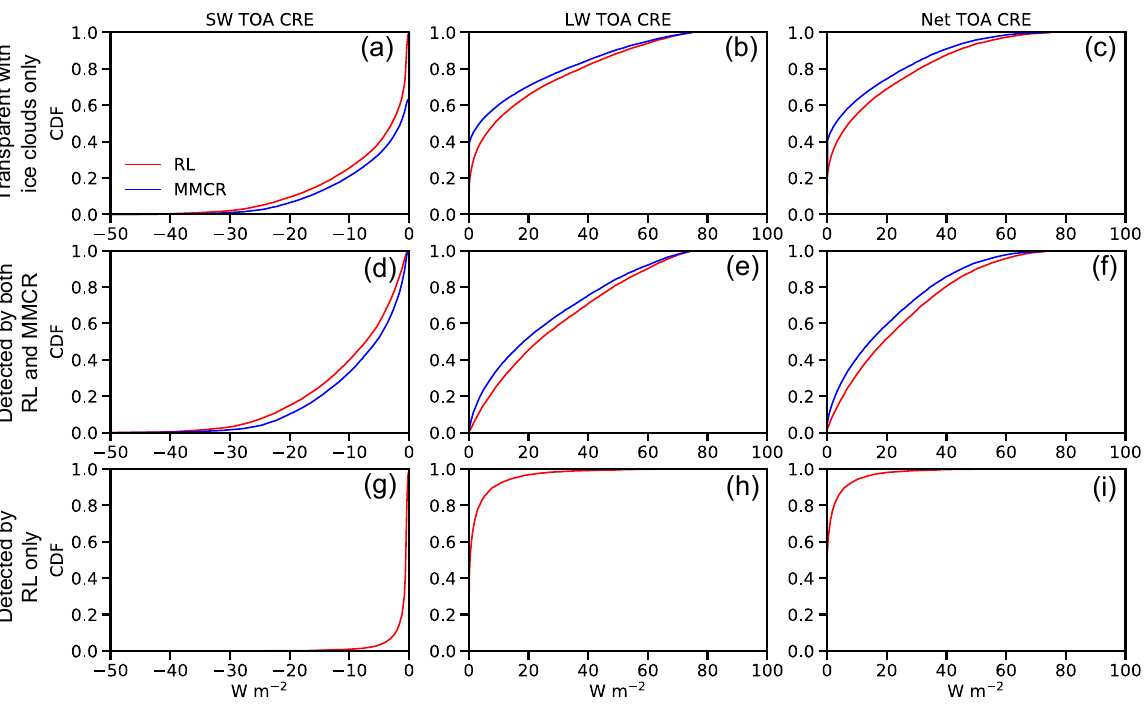
Figure 5. ( a – c ) Cumulative distribution functions (CDFs) of shortwave (SW) (left), longwave (LW) (middle), and net (right) daily-mean cloud radiative effects (CREs, units: W m − 2 ) at the top of atmosphere (TOA) for transparent profiles with ice clouds only that are detected by the Raman lidar (RL; red) and millimeter wavelength cloud radar (MMCR; blue) at the Southern Great Plains (SGP) site from August 2008 to January 2011. ( d – f ) CDFs for transparent profiles with ice clouds only and detected by both RL and MMCR. ( g – i ) CDFs for transparent profiles with ice clouds only that are detected by RL only; thus, only the RL results are shown here.